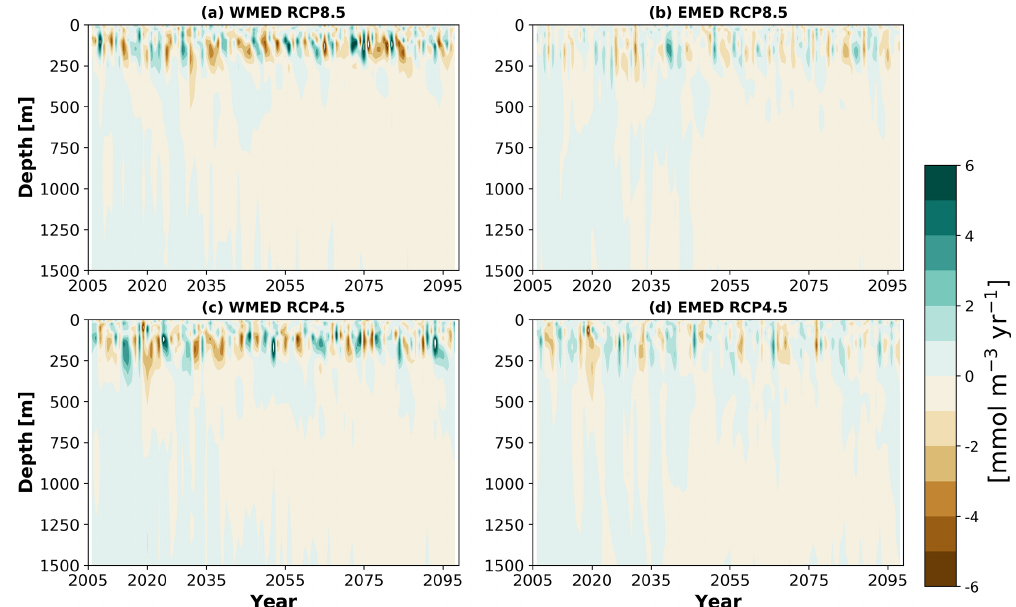
Figure 9. Annual rates of change in dissolved oxygen (mmolm − 3 yr − 1 ) in the Western (a, c) and Eastern (b, d) Mediterranean Sea in RCP8.5 (a, b) and RCP4.5 (c, d) .